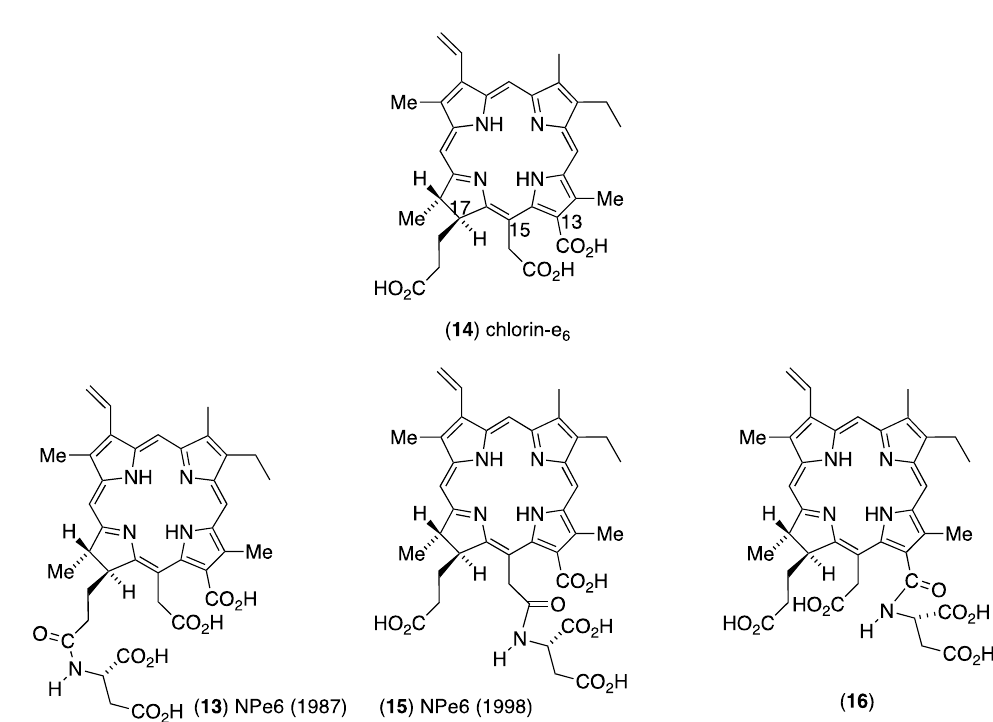
Figure 4. Structures of chlorin-e 6 ( 14 ) and the three possible regioisomers ( 13 , 15 , 16 ) for